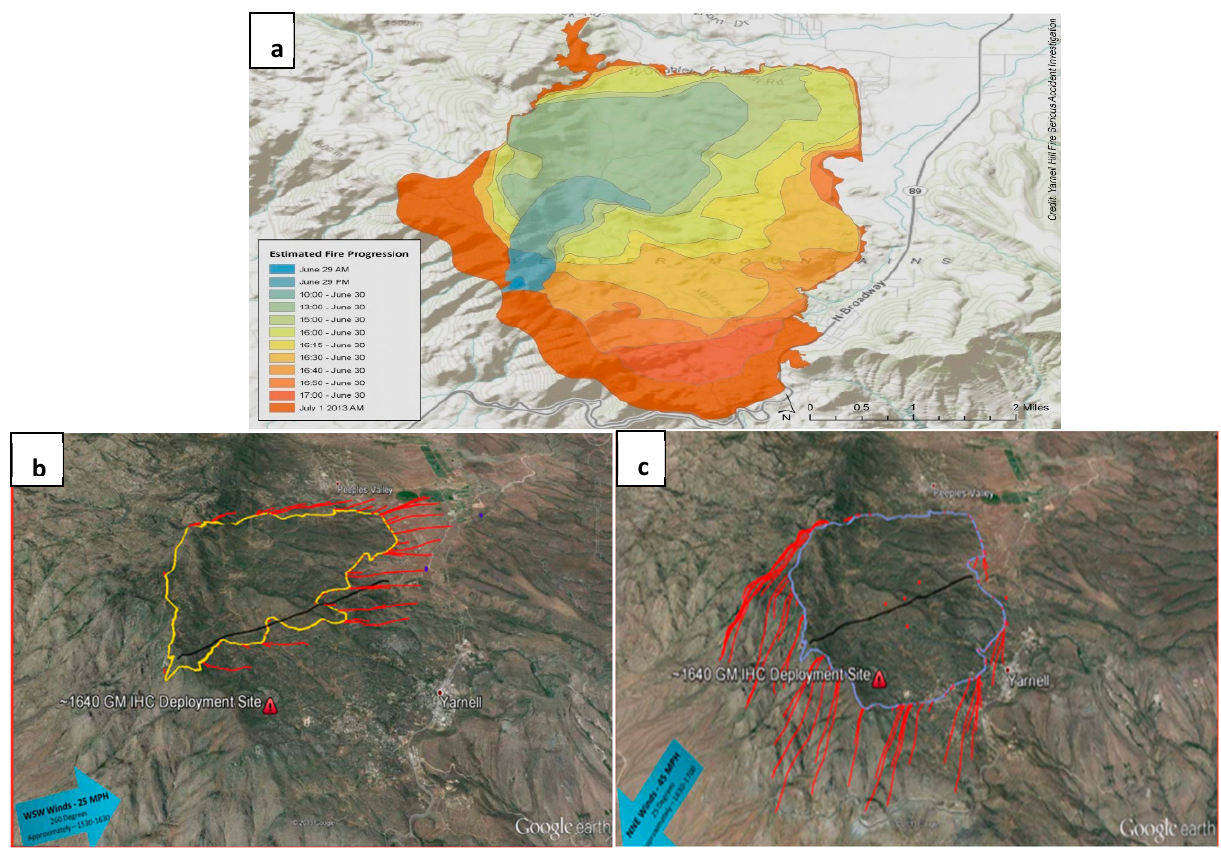
Figure 2. ( a ) Evolution of the Yarnell Hill Fire [5], ( b ) 1530–1630 MST location, and ( c ) 1630–1700 MST location [9].